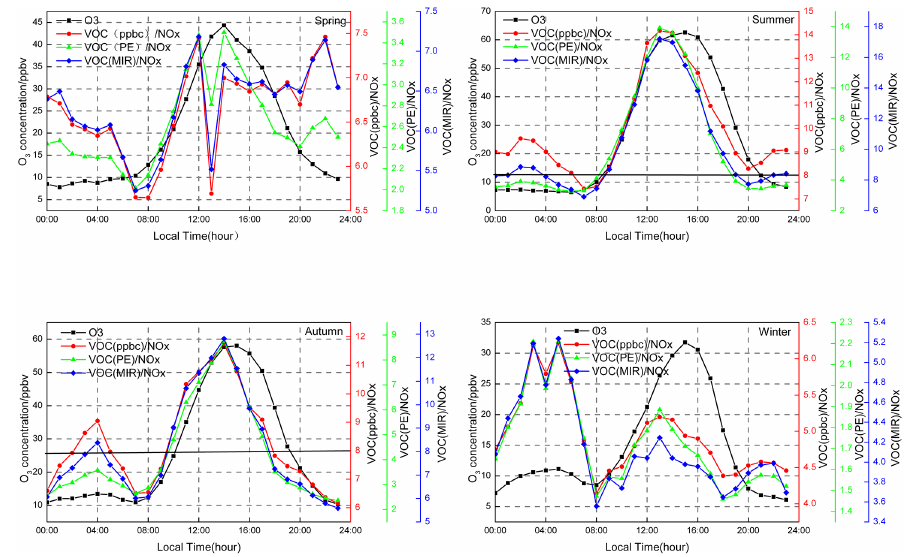
Figure 7. The diurnal patterns of VOC / NO x ratios calculated by three different ways, as well as ozone concentrations, for each season from summer 2011 to spring 2012 at GPACS. Black level lines represent the VOC(ppbC) / NO x ratio of 8 : 1.